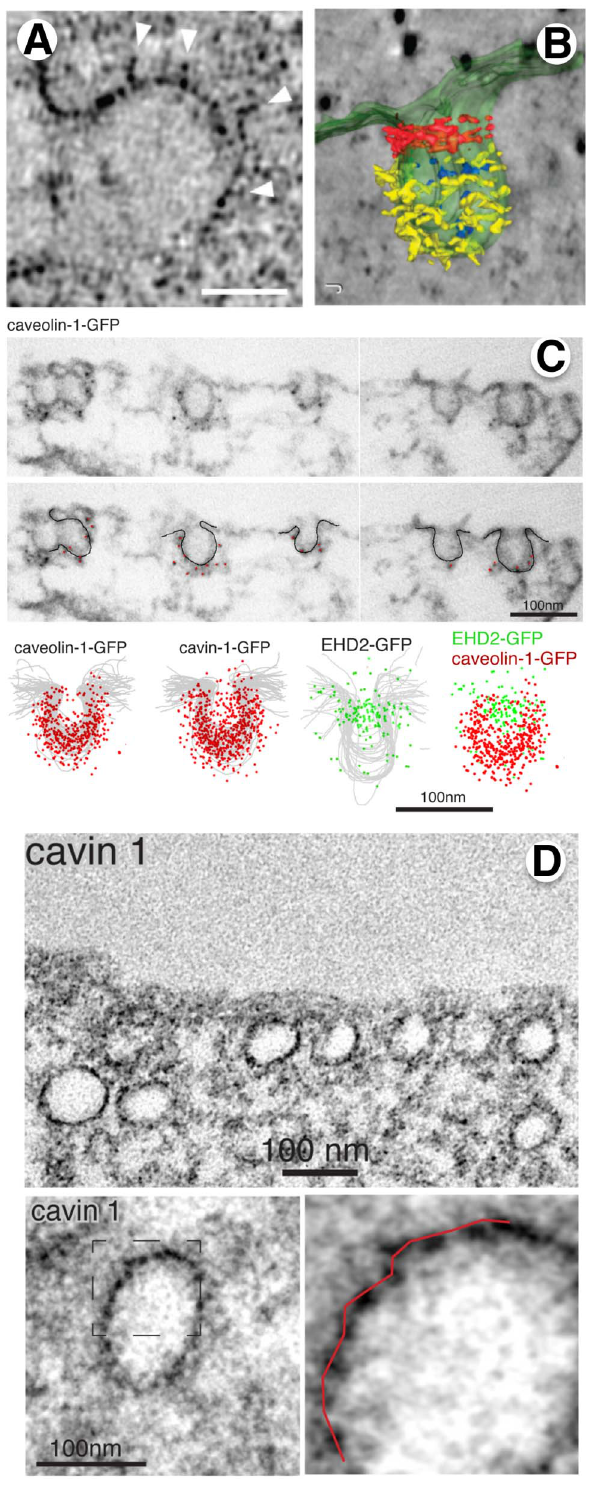
Figure 2. Electron microscopy tomography, immunolocaliza- tion, and the use of genetically encoded electron microscopy markers reveal high resolution ultrastructure of caveolae. (A) Thin section electron micrograph of a single caveolae in 3T3-L1 adipocyte prepared by high pressure-freezing/freeze-substitution re- veals an irregular coat. Bar=30 nm (from [18]). (B) Tomographic reconstruction of caveolae from 3T3-L1 adipocytes reveals electron dense material around the bud and neck (from [18]). (C)